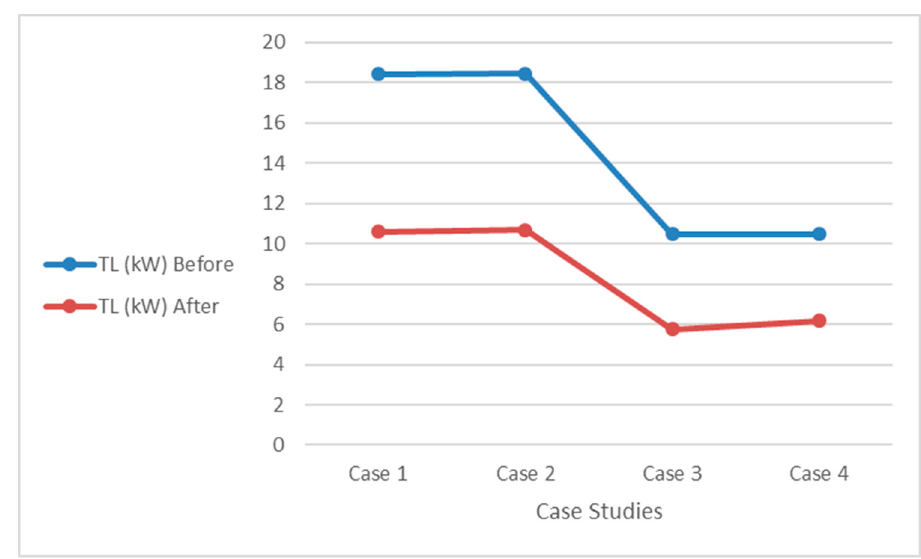
Figure 6. Reduction in Transmission Losses ( TL ) across all case studies.